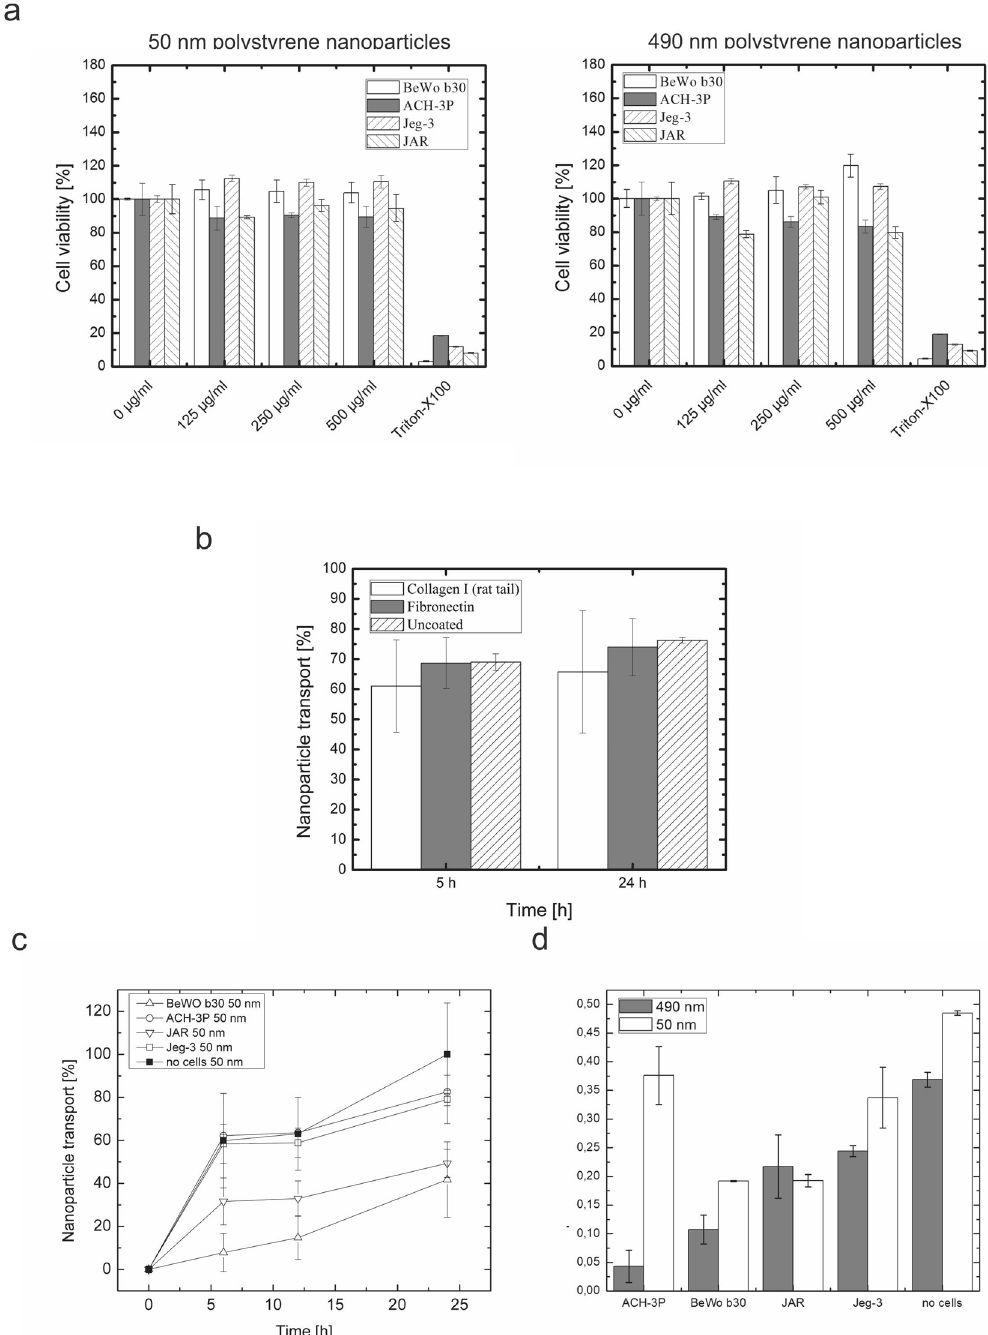
Figure 5. Evaluation of barrier function: Transport of nanoparticles through placental cell barriers. ( a ) Cytotoxicity of fluorescently-labelled 50 nm and 490 nm polystyrene nanoparticles. ( b ) Influence of adhesion promoters on the transport of fluorescently-labelled 50 nm polystyrene nanoparticles through 3 µ m transwell membranes. Values for transwell inserts without cells were set to 100% of membrane-less wells. ( c ) Time- trace of transcellular transport after 6 h, 12 h and 24 h of transport of 50 nm fluorescently-labelled polystyrene nanoparticles through BeWo, ACH-3P, Jeg-3 and JAR cell barriers. ( d ) Apical-to-basal transport ratio after 24 h for 50 nm and 490 nm fluorescently-labelled polystyrene nanoparticles through BeWo, ACH-3P, Jeg-3 and JAR cell barriers. Data points are mean values ± SD for n = 3